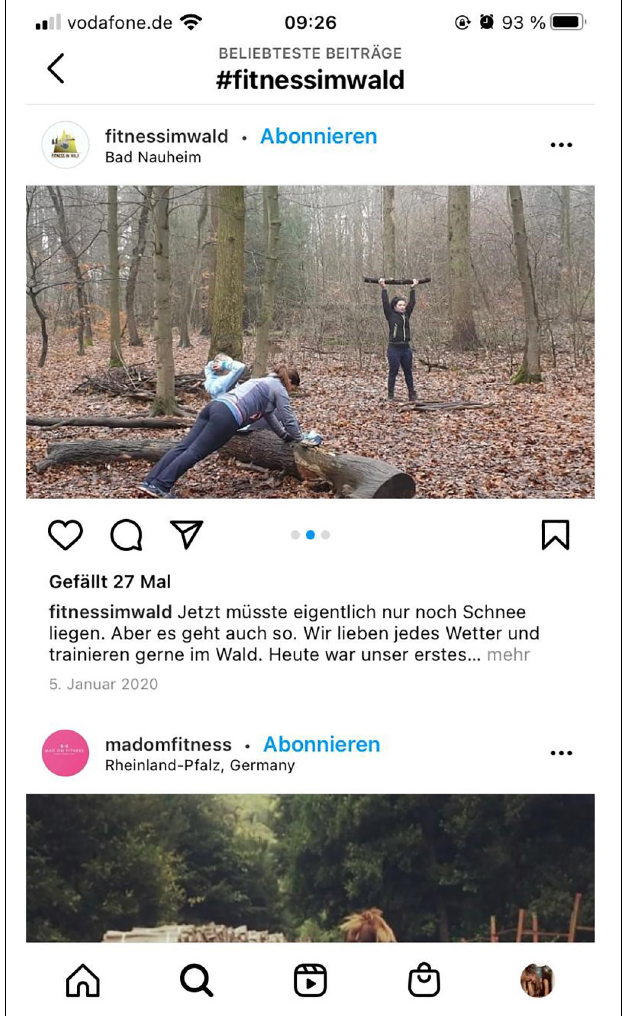
FIGURE 3 | Forest as gym (source: